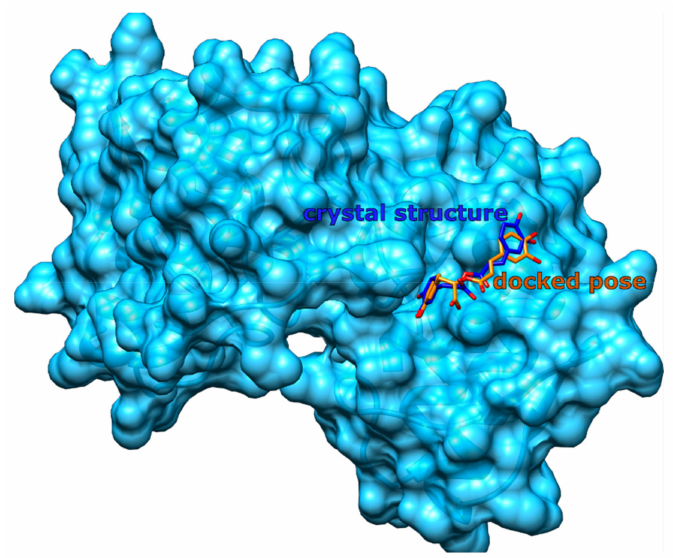
Figure 14. A successful redocking of rosmarinic acid to the crystal structure of phospholipase A2 (PDB ID: 3QNL) from the snake venom (depicted in blue ribbons and transparent surfaces). The stick structure of rosmarinic acid with blue carbons represents the native ligand position found in the crystal structure, while the structure with orange carbons displays the redocked structure. Hydrogen atoms are not shown for clarity. The RMSD between the two rosmarinic acid structures is 1.3